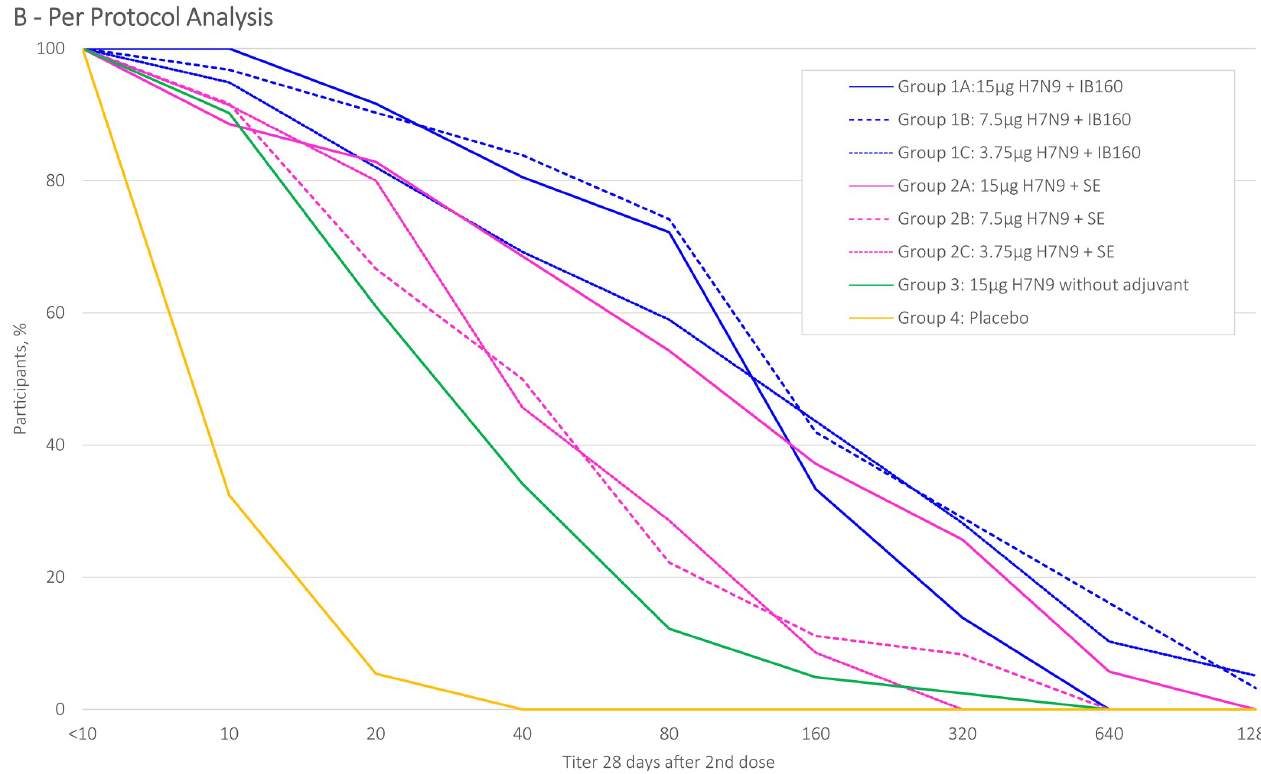
Fig 7. MNT antibody against H7N9 reverse cumulative distribution curve after 28(+7) days post 2nd dose administration, per protocol analysis.